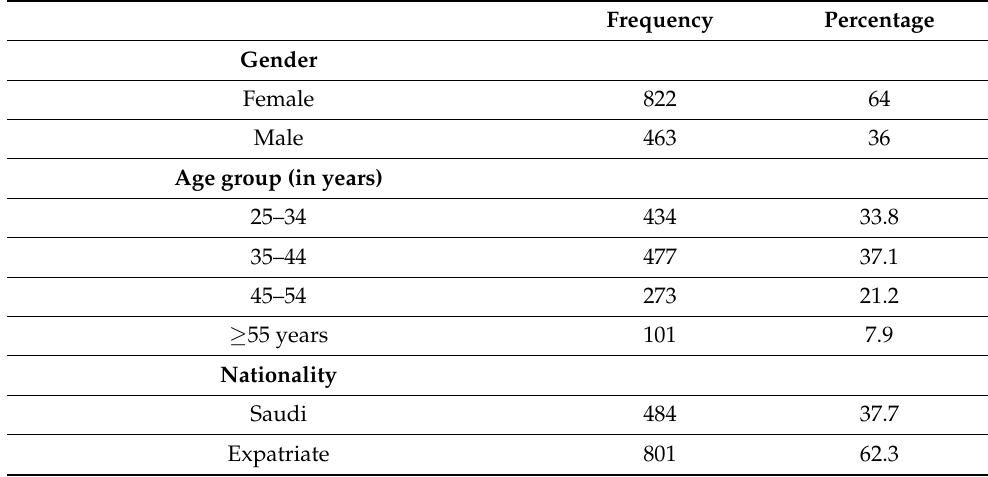
Table 1. Descriptive analysis of the 1285 HCW’s sociodemographic characteristics and professional